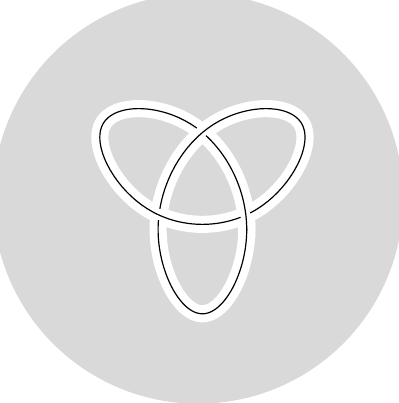
Figure 1. The knot complement manifold M corresponding to the trefoil knot (gray region). It is constructed by removing from S 3 a small tubular neighbourhood K tub (white region) of the knot (black